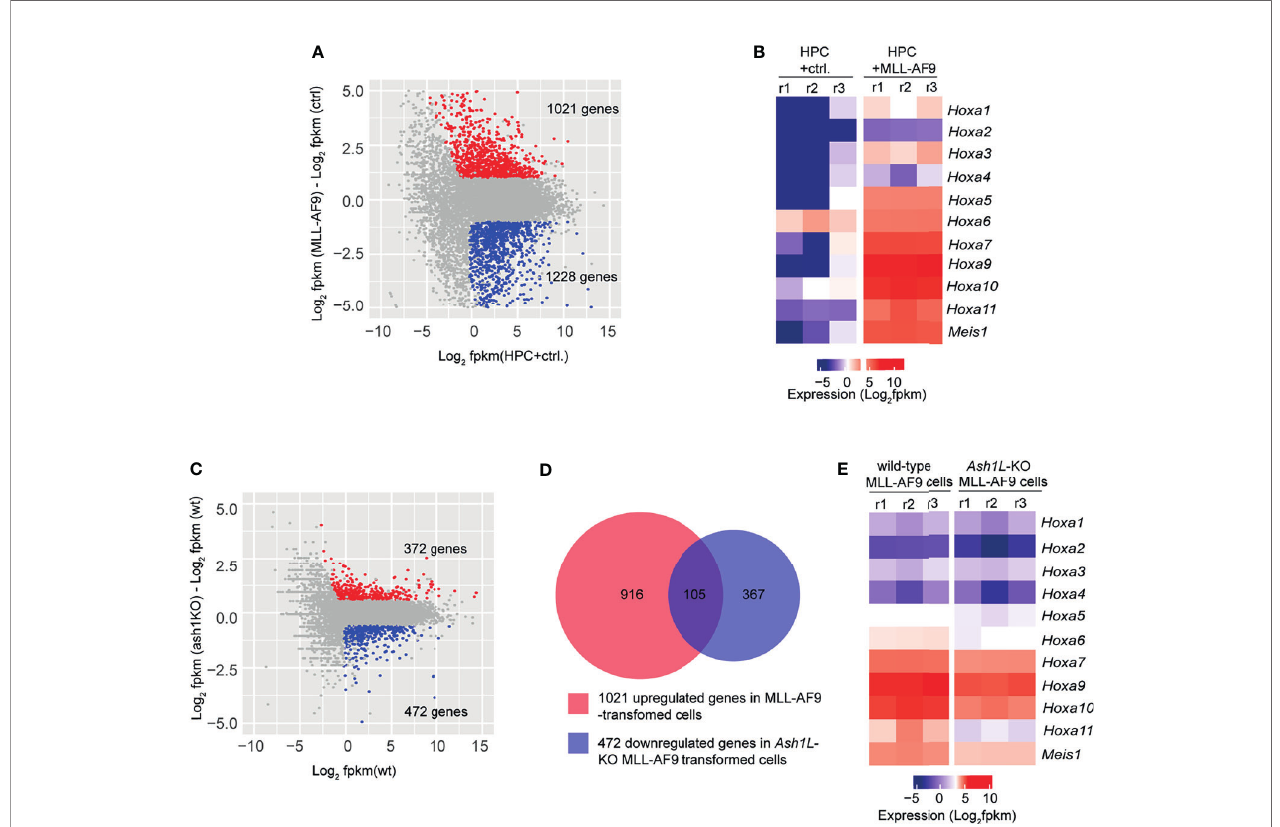
FIGURE 5 | ASH1L facilitates the MLL-AF9-induced leukemogenic gene expression. (A) Plot showing 1021 up- and 1228 down-regulated genes in the MLL-AF9- transformed cells compared to the normal HPCs. (B) Heatmap showing the upregulation of Hoxa gene cluster and MeisI in the MLL-AF9-transformed cells compared to normal HPCs. (C) Plot showing 372 up- and 472 down-regulated genes in the Ash1L -KO MLL-AF9-transformed cells compared to the wild-type MLL- AF9-transformed cells. (D) Venn diagram showing the 105 genes upregulated in the MLL-AF9-transformed cells and downregulated in the Ash1L -KO cells. (E) Heatmap showing the Hoxa gene cluster and MeisI downregulated in the Ash1L -KO cells compared to the wild-type MLL-AF9-transformed